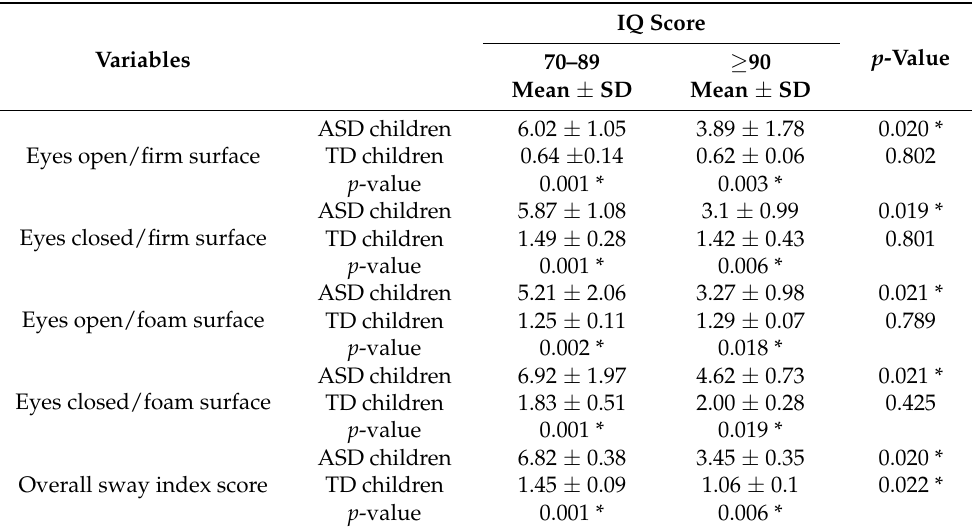
Table 3. Comparison of postural stability testing conditions of ASD and TD children based on IQ